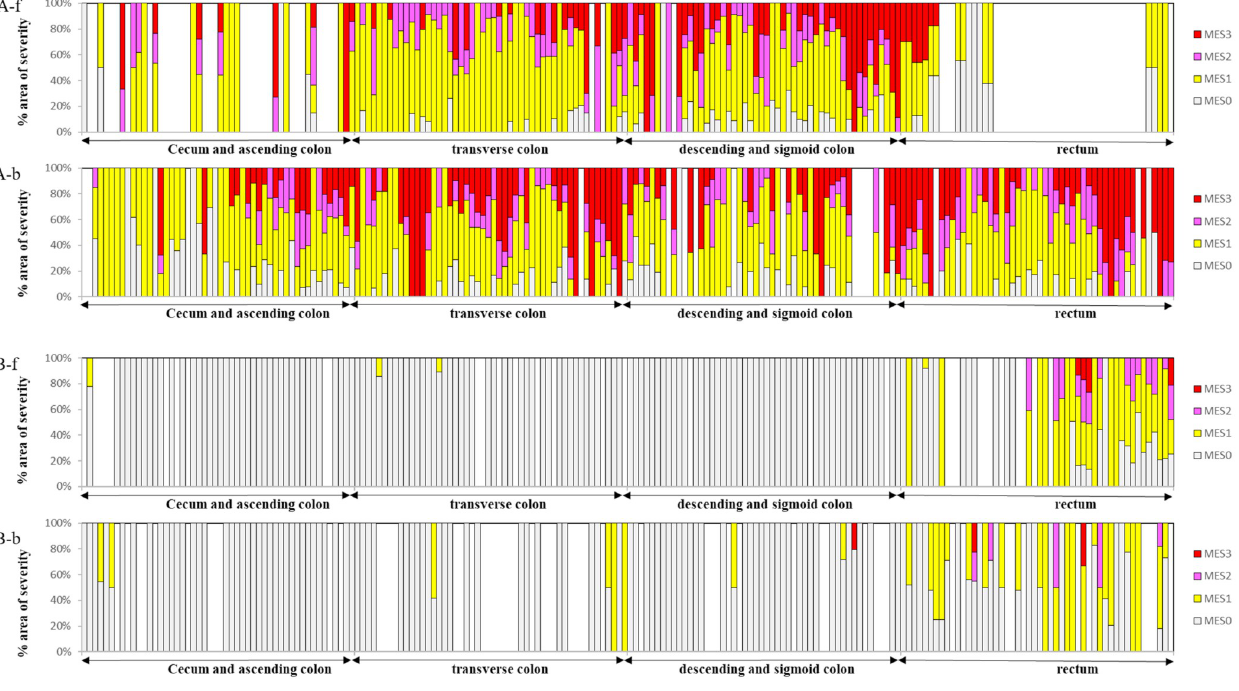
Fig 5. Examples of topography map of severity in the same patient along the entire length of the colorectum (the cecum and ascending, transverse, descending and sigmoid, and rectum) before (A) and after (B) therapeutic intervention. Suffix (-f) and (-b) indicate data files from forward and backward cameras, respectively. Severity is expressed by the stacked column composed of light gray (MES0%area), yellow (MES1%area), magenta (MES2%area), and red (MES3% area). The blank column corresponds to a still picture estimated as an inadequate condition for analysis.